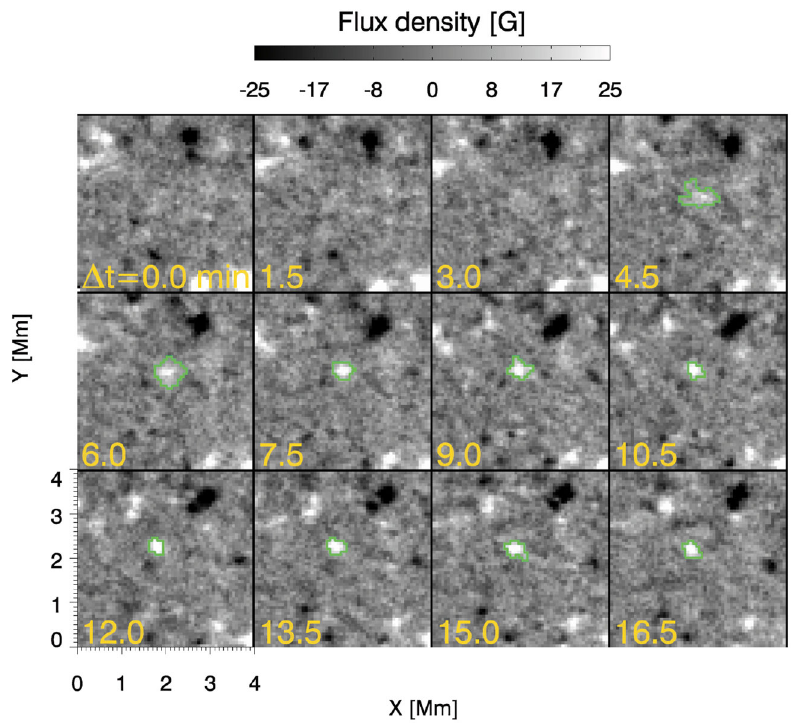
Fig.19 AppearanceofunipolarfluxconcentrationsinthesolarIN.ThiseventwasobservedwiththeHinode NFI at a cadence of 1.5 min. The data belongs to the Hinode Operation Plan 151 ( Flux replacement in the solarnetworkandinternetwork ).Thecontoursoutlineanisolatedmagneticpatchwithnoobviousopposite- polarity patches nearby. It probably appears as a consequence of the coalescence of unresolved magnetic flux. There are hints of very weak positive polarity flux at the position of the feature one frame before the element is detected. Note also the contraction of the patch during the first frames. Image reproduced with permission from Goši´c